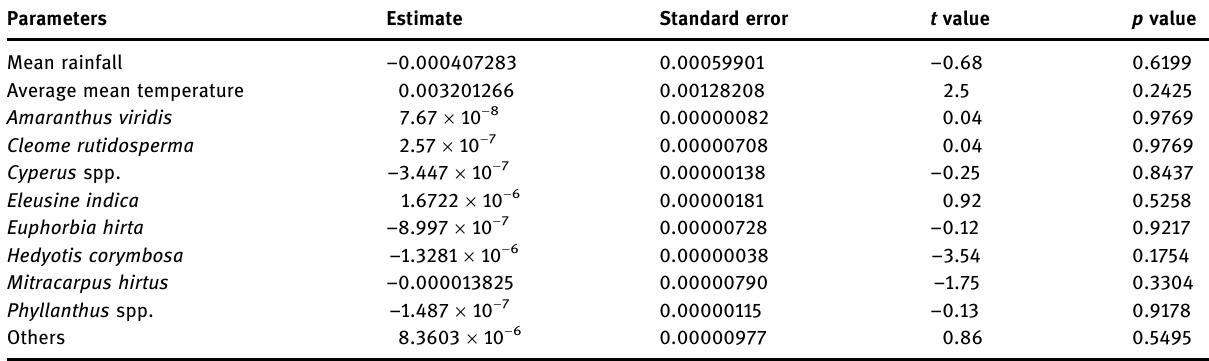
Table 3: E ff ect of mean temperature, mean rainfall, and weed species on corn yield using General Linear Model